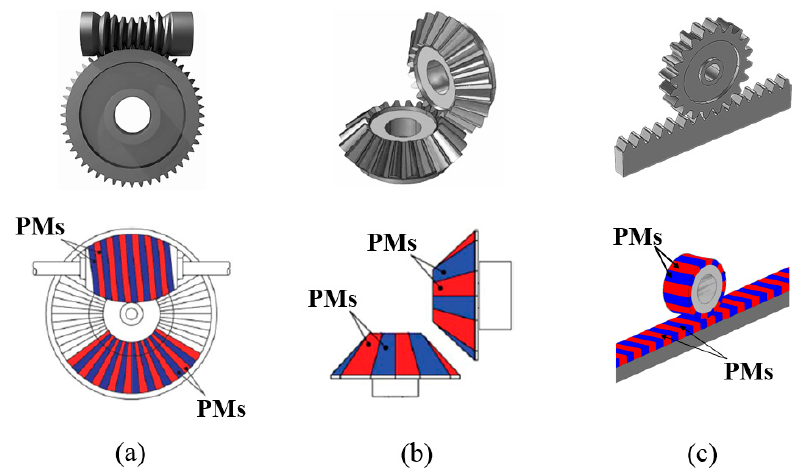
Figure 4. Mechanical gears and their equivalents MGs: ( a ) Worm; ( b ) Bevel; ( c ) Rack-Pinion.